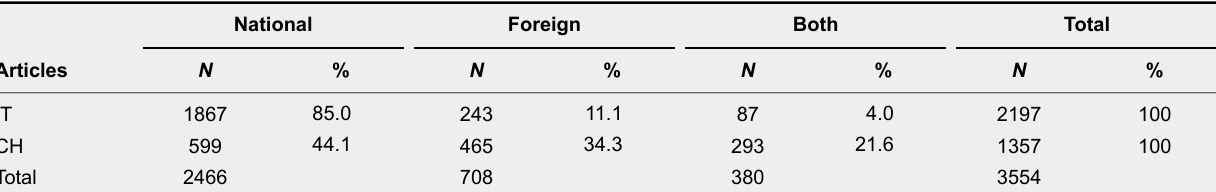
Corpus of Retrieved Articles for Lexicographical Analysis by Focus of Tax-Related News: Internal (National), International/Foreign (International), Both National and International